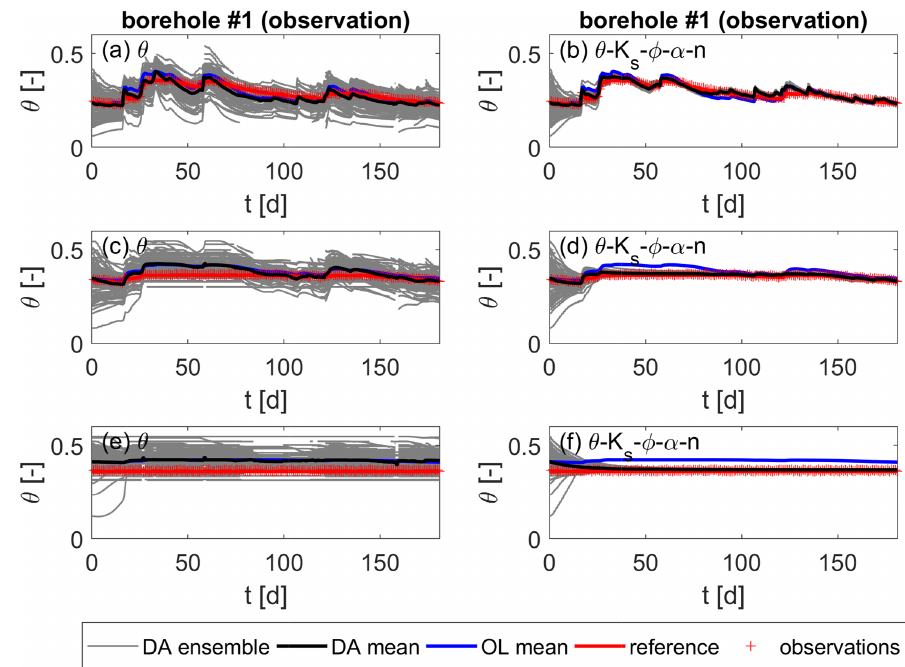
Figure 7. Soil moisture over time for the heterogeneous scenario at one observation location. Values are taken at z 1 = 0 . 33m, z 2 = 0 . 75m, and z 3 = 0 . 95m below the surface, from top to bottom. (a, c, e) Updates of soil moisture only. (b, d, f) Joint updates of soil moisture and all parameters.